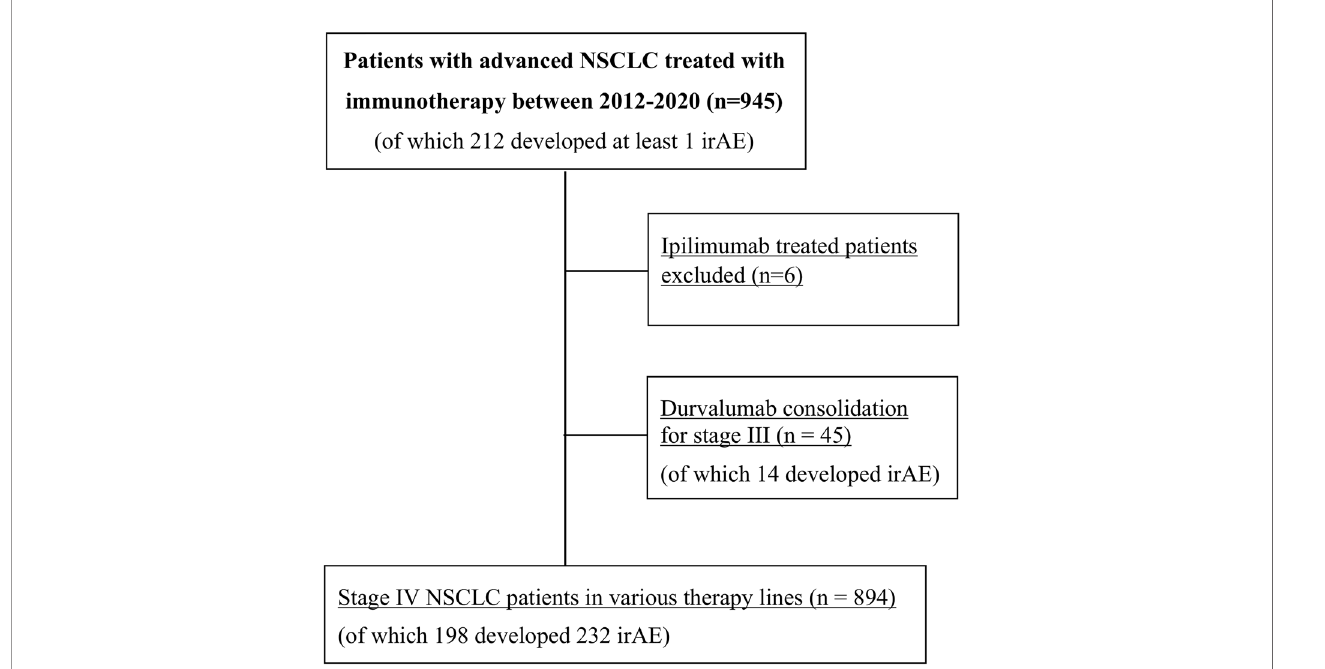
FIGURE 1 | Flowchart of study patients. NSCLC, non-small-cell lung cancer; irAE, immune-related adverse